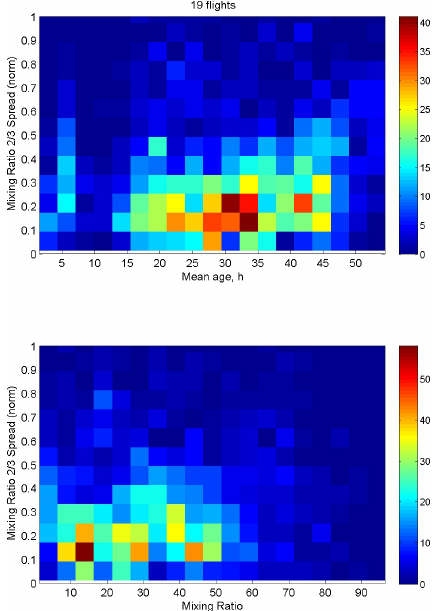
Figure 12: Frequency of occurrence of CO tracer age spread along the P3 flight tracks vs. simulated mean tracer age (top) and simulated mixing ratio (bottom) for all points with valid CO measurements below 1000 m AGL.